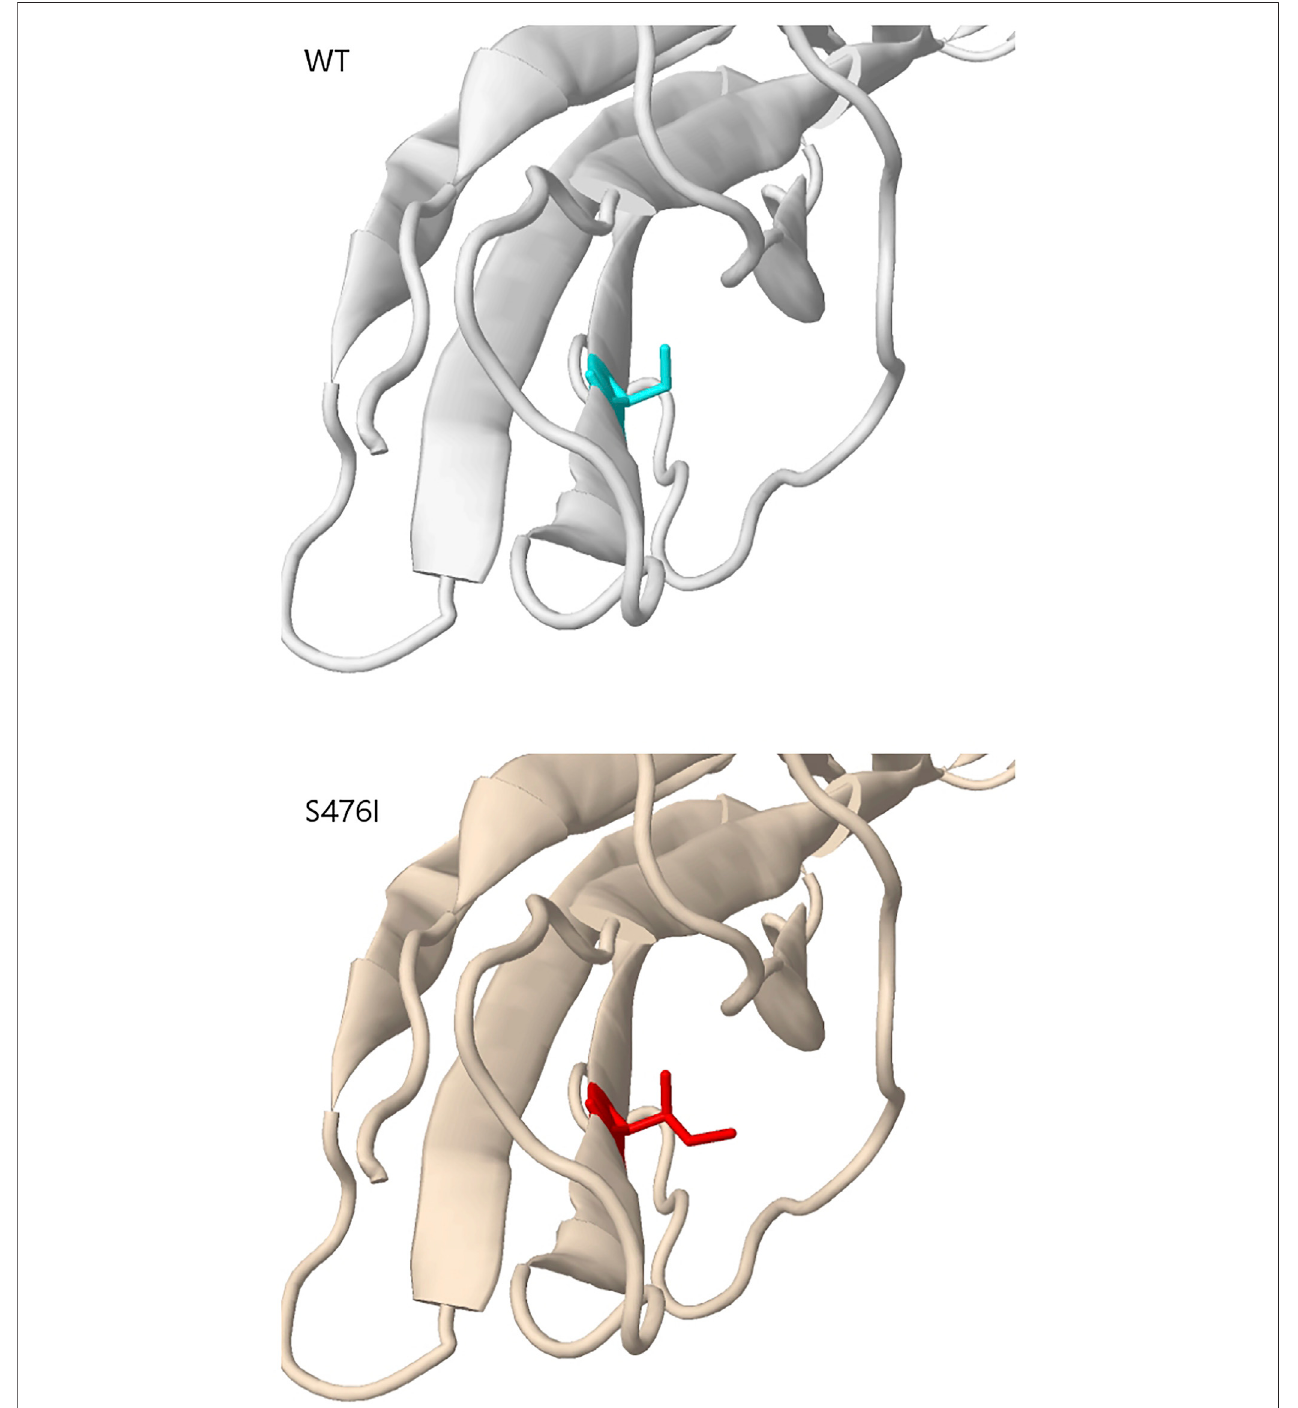
FIGURE 3 | Missense3D predicts the tertiary structure changes introduced by KIT p.Ser476Ile.